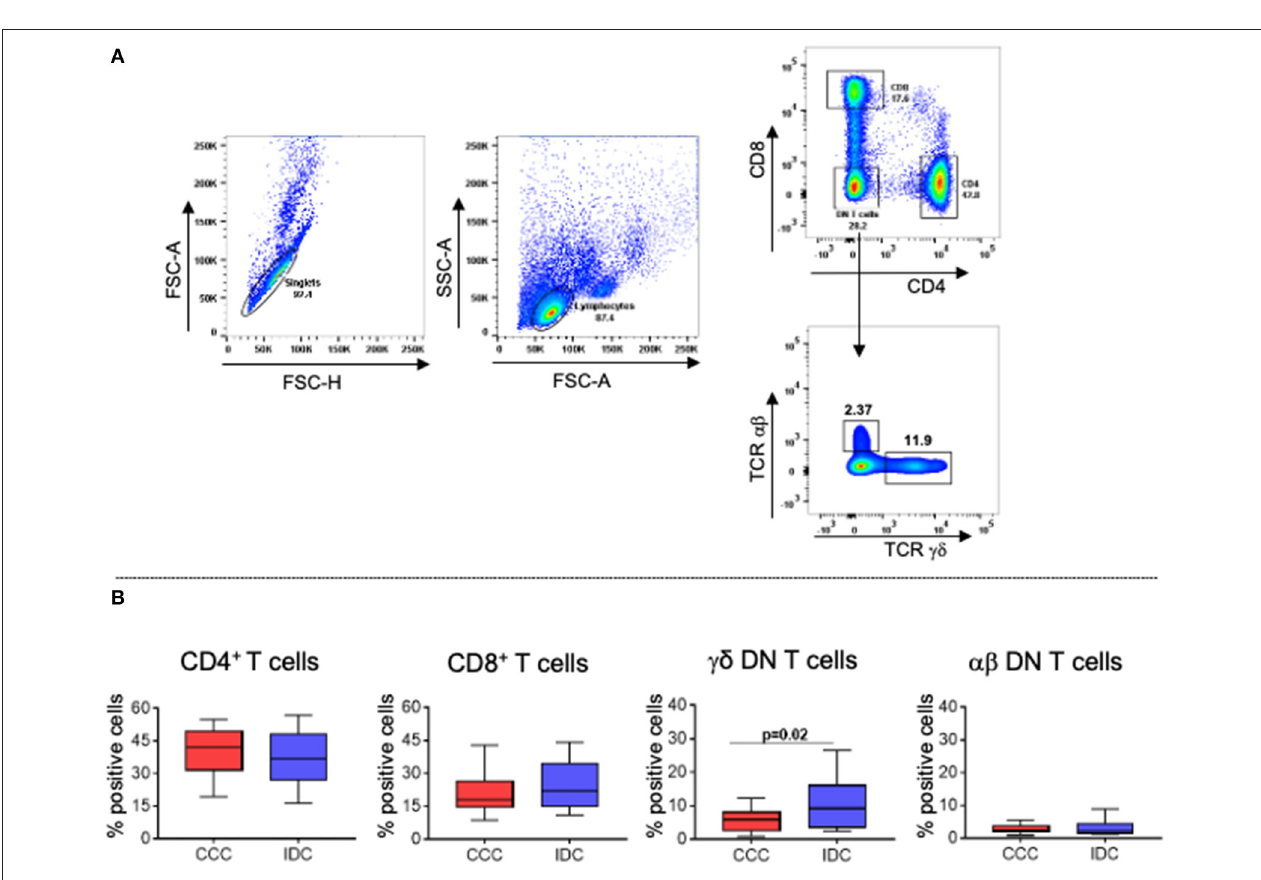
FIGURE 2 | Frequency of different T lymphocyte subpopulations in peripheral blood of patients with chronic Chagas cardiomyopathy and idiopathic cardiomyopathy. (A) Representative dot plots of the analysis strategy used in the study: To remove doublets, the parameters FSC-A × FSC-H were used; lymphocytes were selected according to size (FSC-A) and granularity (SSC-A) parameters. For phenotypic separation of cell subpopulations, CD8 and CD4 surface markers were selected, followed by selection of CD4 − CD8 − cells to identify gamma − delta + and alpha − beta + DN T cells. (B) Frequency of CD4 + T cells, CD8 + T cells, gamma − delta + DN T cells (CCC, n = 17; IDC, n = 13), and alpha − beta + DN T cells (CCC, n = 10; IDC, n = 10). Graphs are expressed as boxplots, with the minimum and maximum values